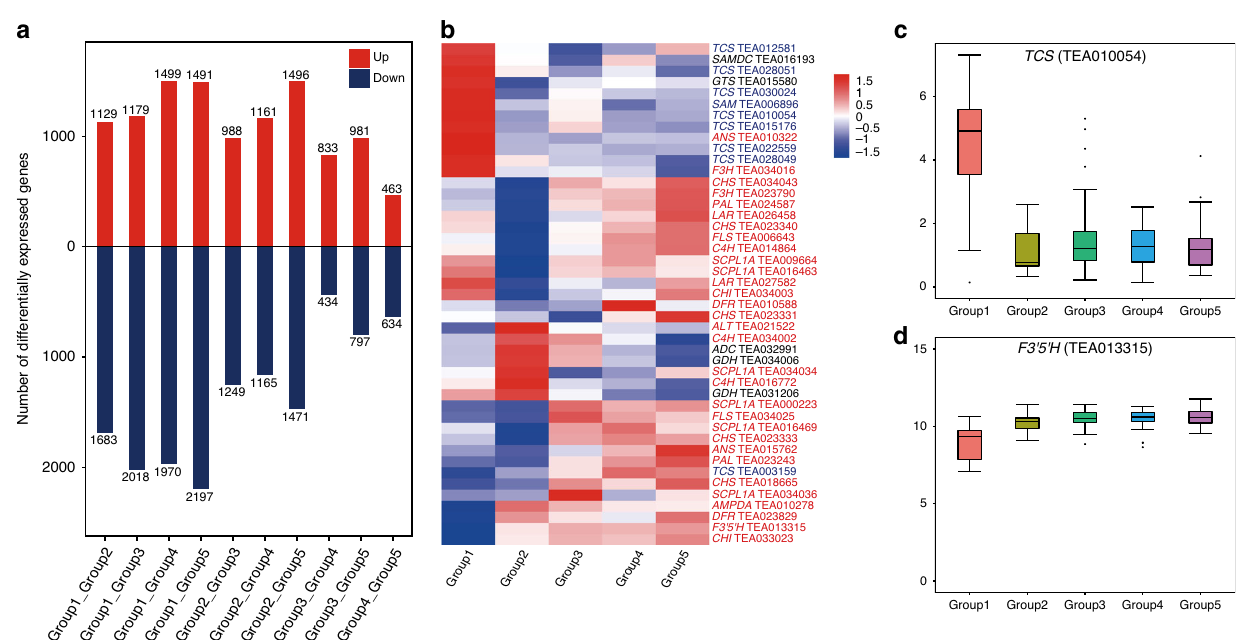
Fig. 5 Differentially expressed genes identi fi ed in pairwise comparisons of fi ve groups of tea accessions. a Number of differentially expressed genes in pairwise comparisons of fi ve groups of tea accessions. Numbers of up- and downregulated genes are indicated in red and blue, respectively. b Heatmap showing the expression patterns of genes that are known to be involved in the biosynthesis of catechins (in red), caffeine (in blue), and theanine (in black), and show signi fi cant changes in expression in at least one pairwise comparison. c , d Box plots of gene expression values (log2-transformed counts per million) of TCS and F3 ′ 5 ′ H in different tea groups. ( n = 25 for Group 1, 9 for Group 2, 28 for Group 3, 26 for Group 4, and 34 for Group 5). Boxes = interquartile ranges, middles = medians, whiskers = 1.5 × the interquartile range, single points = outliers. Source data underlying b , c , and d are provided as a Source Data fi TCS (TEA010054), which encodes an S -adenosyl- L -methionine